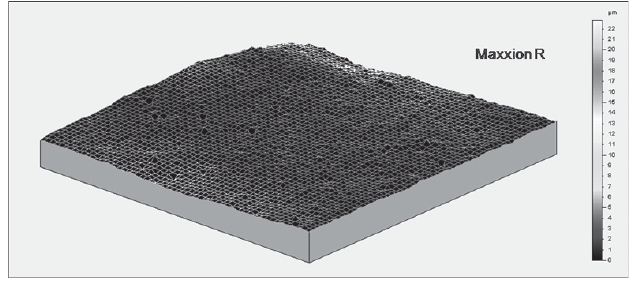
Fig. 3. 3D image of the profile of the glass ionomer cement Maxxion R.